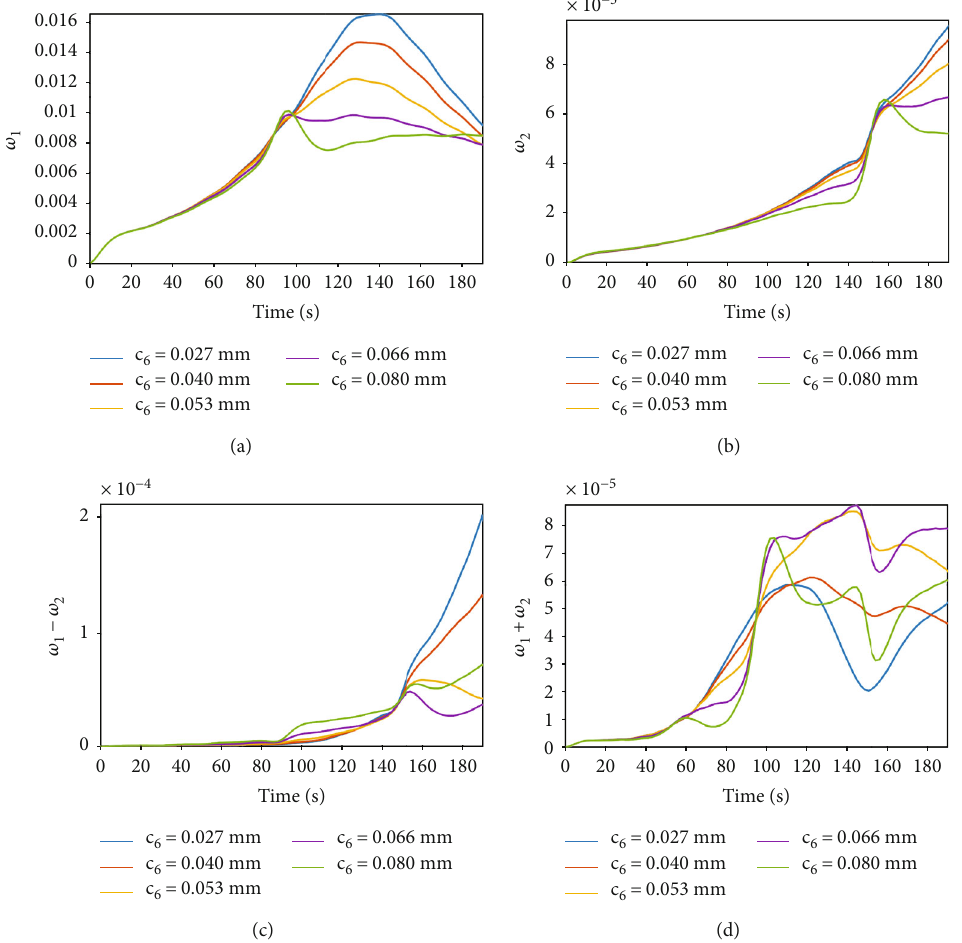
ω ω − ω ω + ω 1 ; (b) 2 ; (c) 1 2 ; (d) 1 2